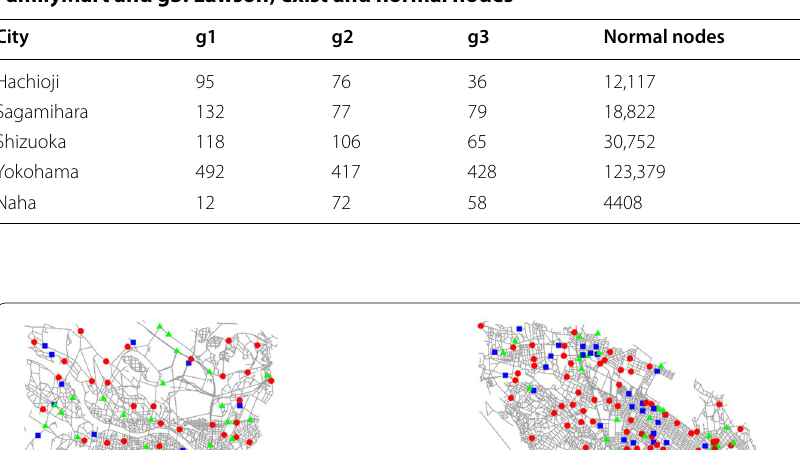
Table 2 The numbers of nodes where stores belonging to each group (g1: 7-Eleven, g2: FamilyMart and g3: Lawson) exist and normal nodes